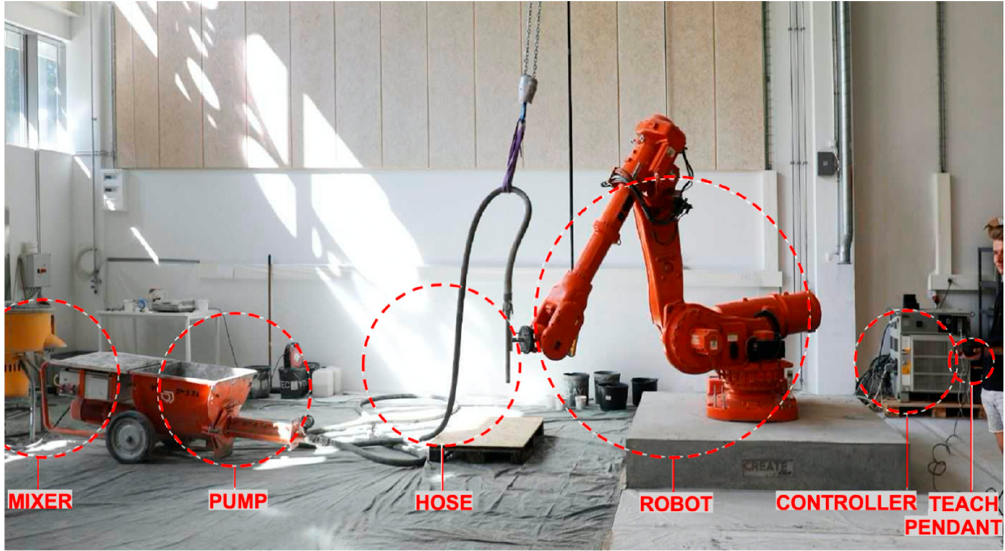
Figure 1. Components of an AM robotic arm for concrete printing.